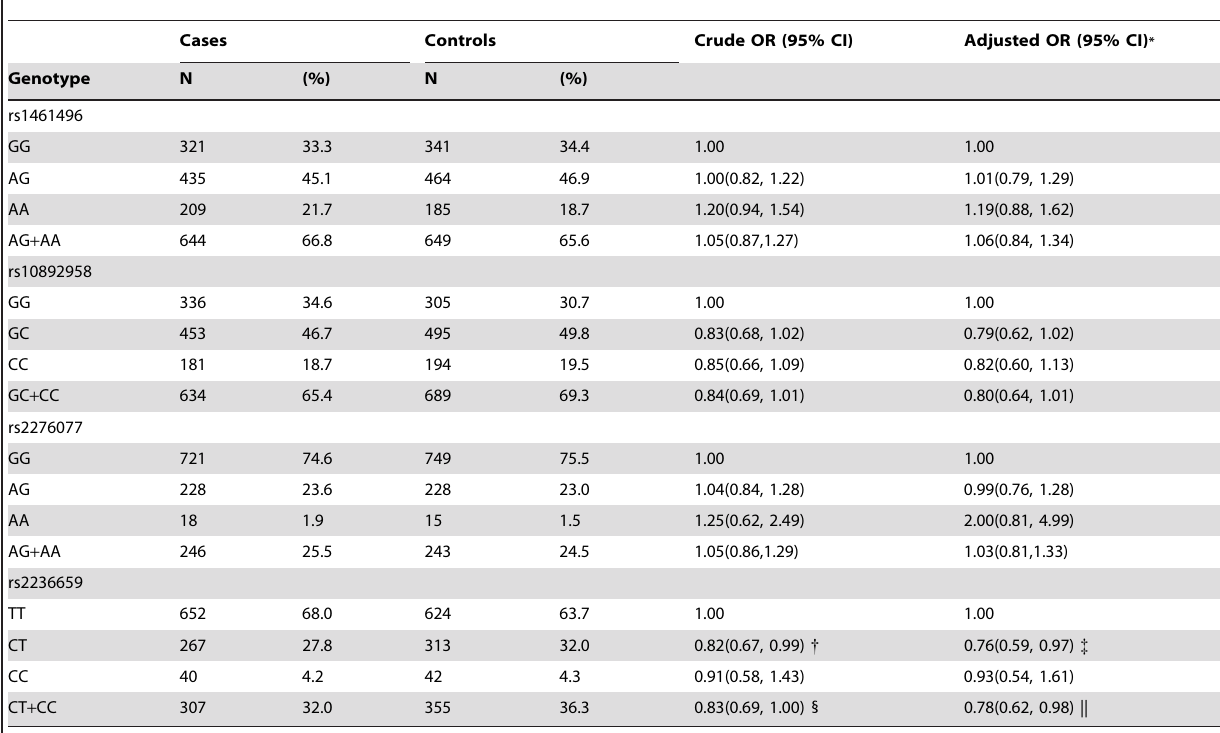
Table 3. Analysis of associations between the HSPA8 polymorphisms and risk of CHD.